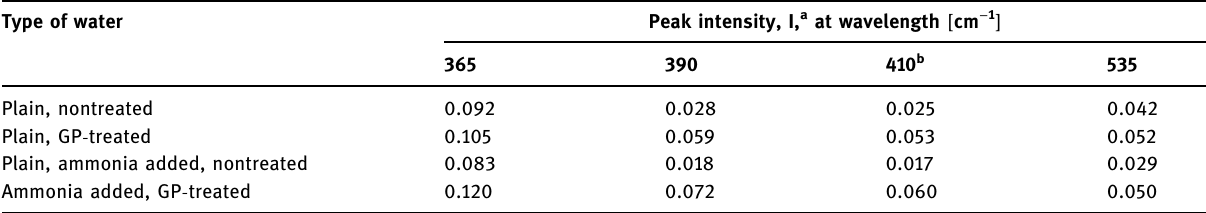
Table 1: Peak intensity in the Raman spectra of deionized water with and without ammonia prior and after GP treatment Type of